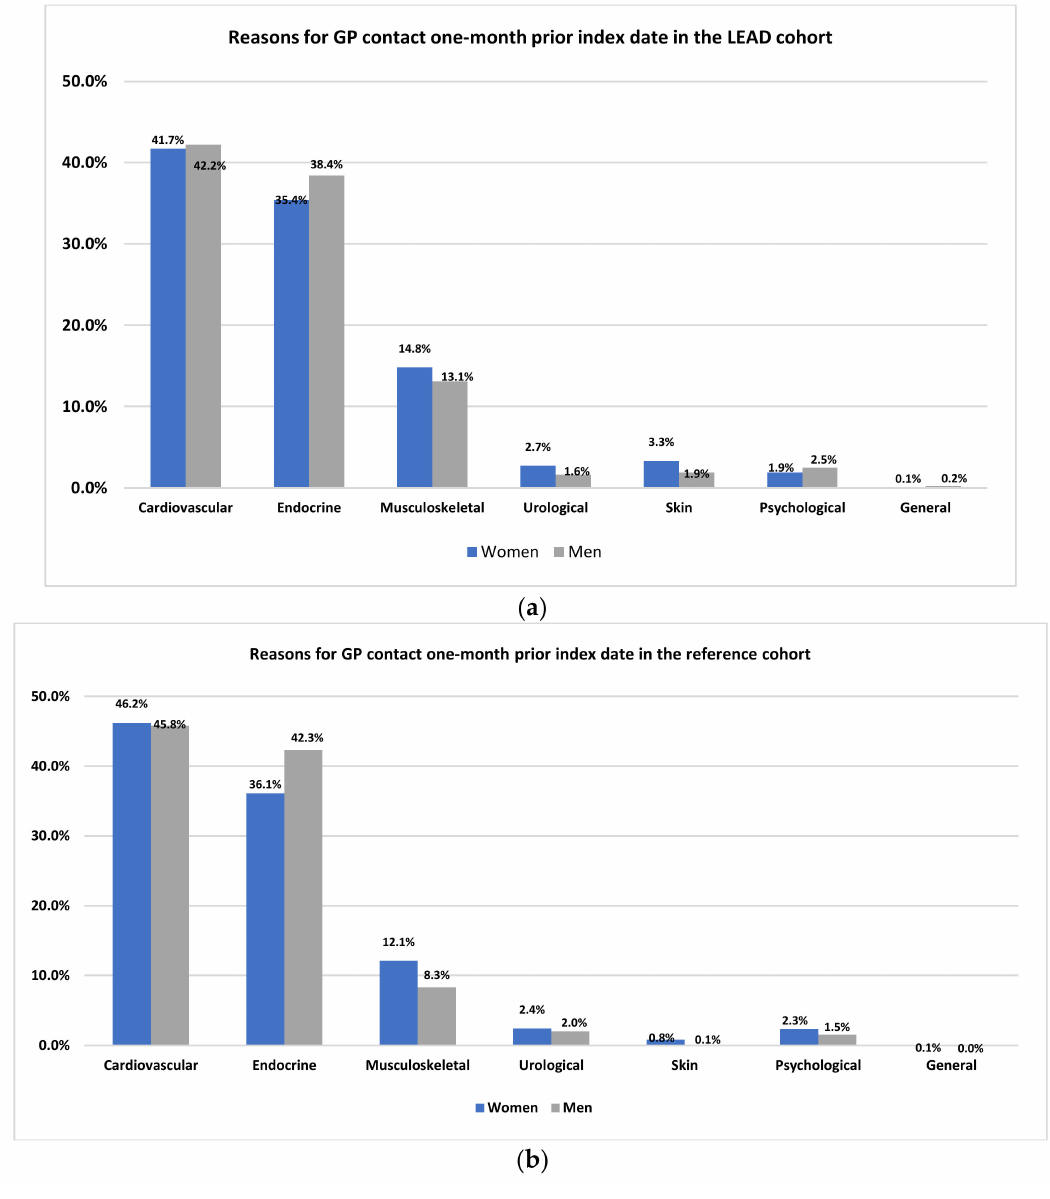
Figure 1. ( a ) Reasons for GP contact one month prior to index date in the LEAD group. LEAD: lower-extremity arterial dis-ease. ( b ) Reasons for GP contact one month prior to index date in the reference